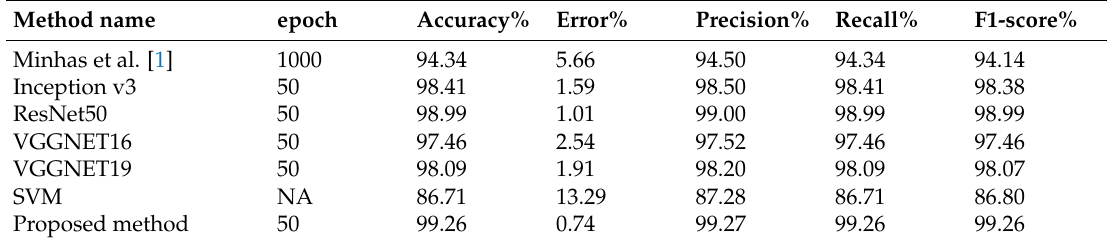
Table 7. Model performance evaluation and comparison-table with the state-of-the-art